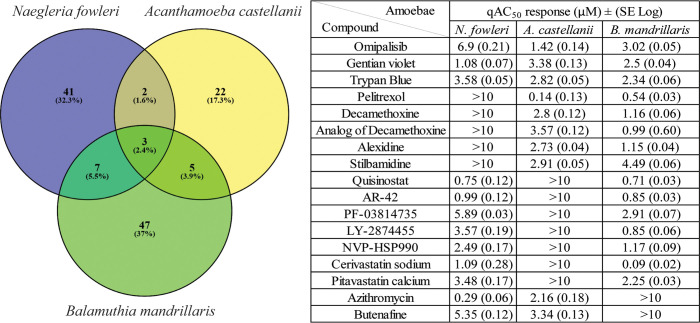
Comparison of all hits shared between the amoebae.Venn diagram illustrating the amount of individual and shared hits found between genera of pathogenic amoebae. The table compares the qAC50 μM response.